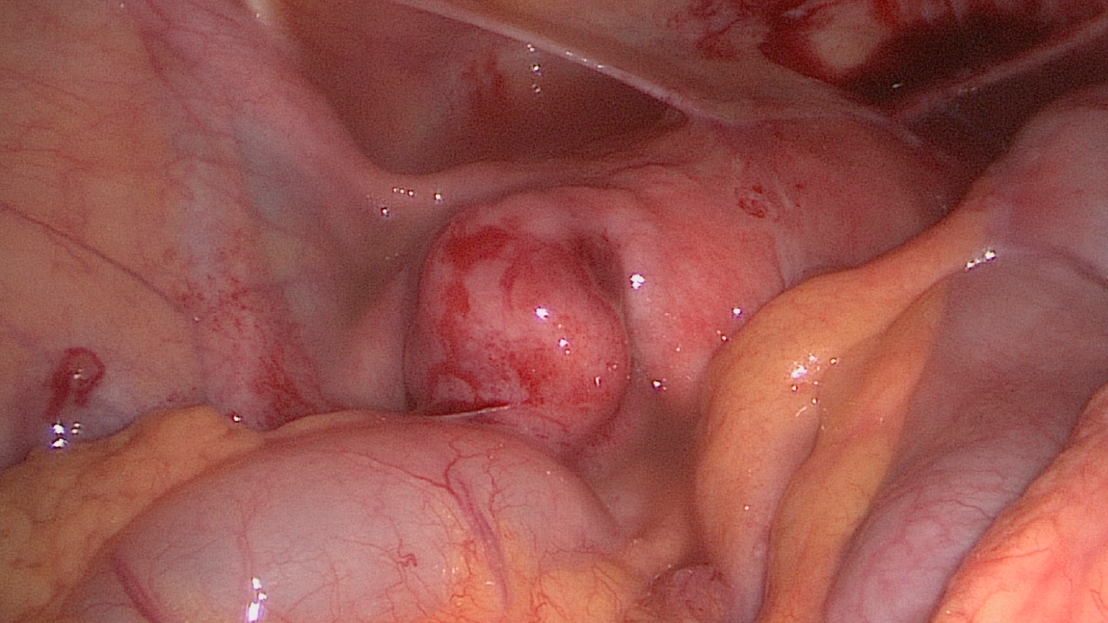
Figure 2. Intermediate tubal disease according to classification by Hull and Rutherford.